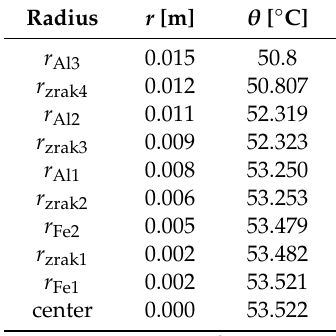
Table 4. Temperatures in dependency from radius and environmental conditions.